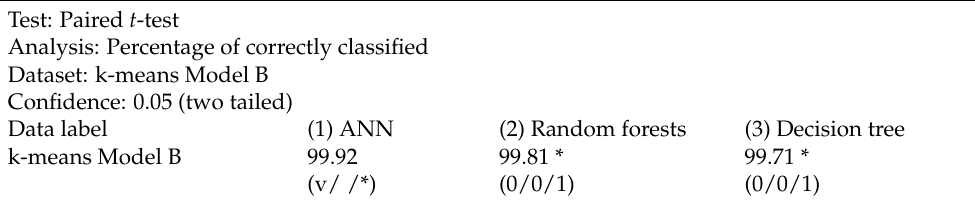
Table 13. Classification performance t -test